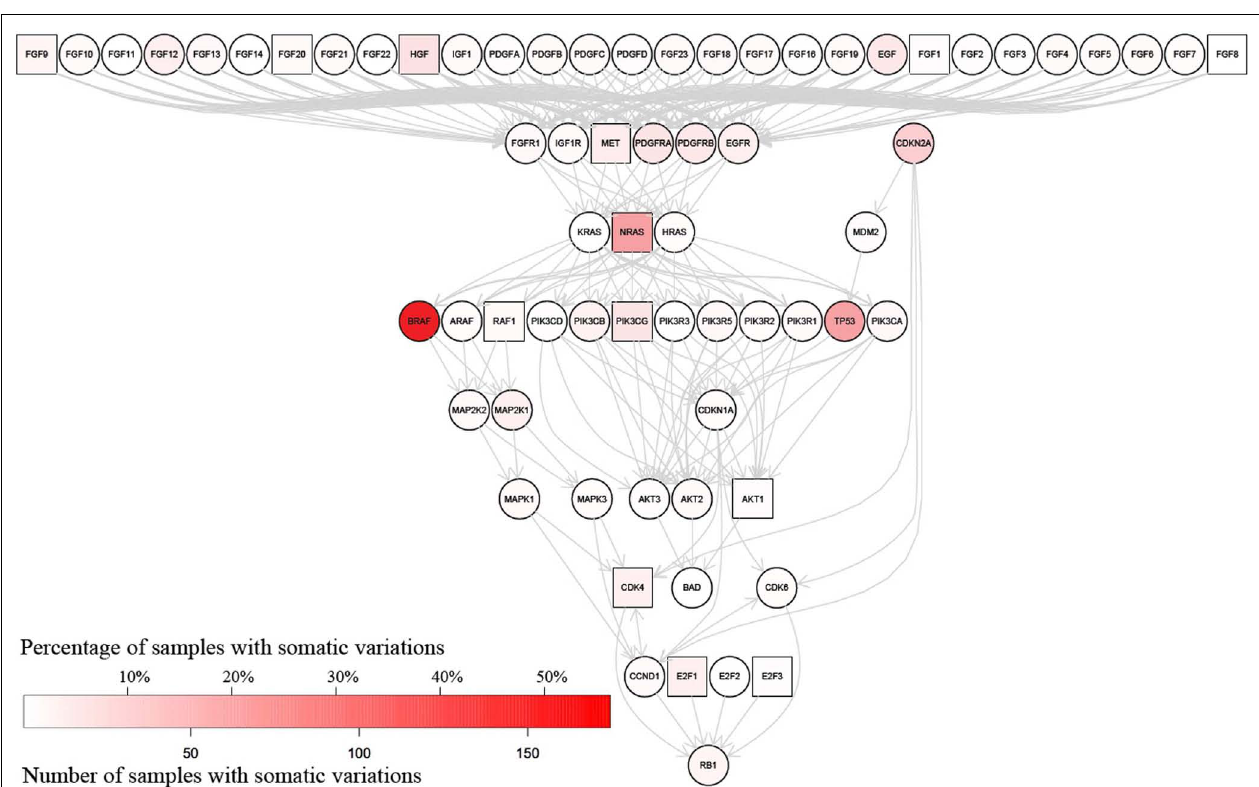
FIGURE 4 | Somatic variations in genes encoding proteins of the KEGG “Melanoma” signaling pathway .The color of each gene’s node indicates the number of melanomas in which at least one non-synonymous somatic variation has been identified; white indicates no melanomas with reported somatic variation in the gene, while the degree of red saturation indicates the number of melanomas containing somatic variations in that gene (refer to color key in lower left). Square nodes